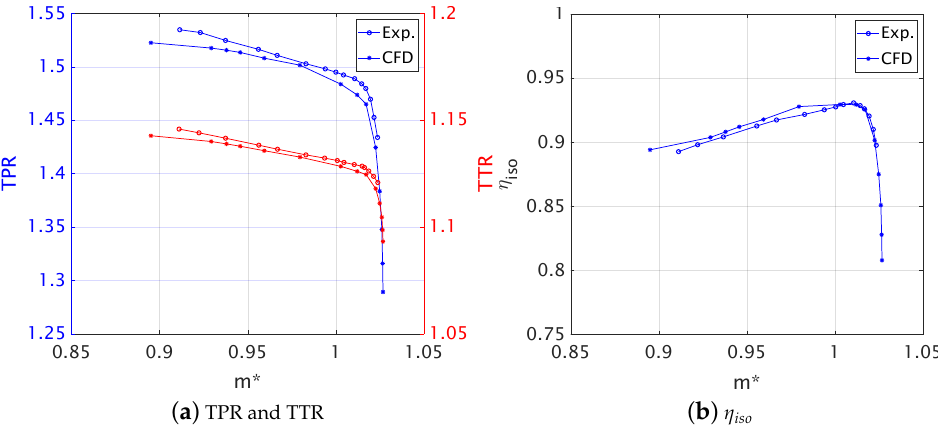
Figure 4. Rotor-alone characteristic maps for CFD and experiments.